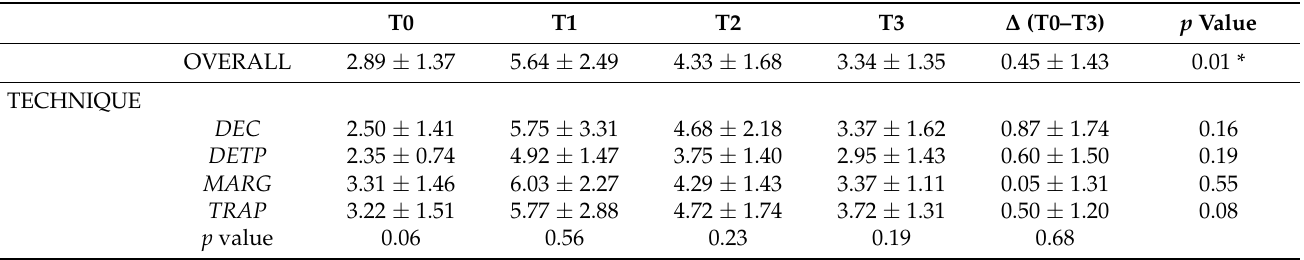
Table 7. Second molar distal site PPD. Values are presented in mm as mean ( ± standard deviation). T0 T1 T2 T3 ∆ (T0–T3) p Value OVERALL